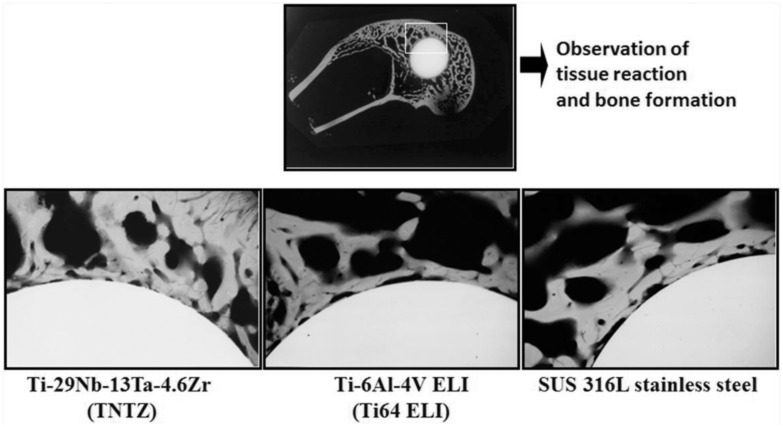
CMR. Photograph of boundary of each specimen and bone at 8 weeks after implantation.